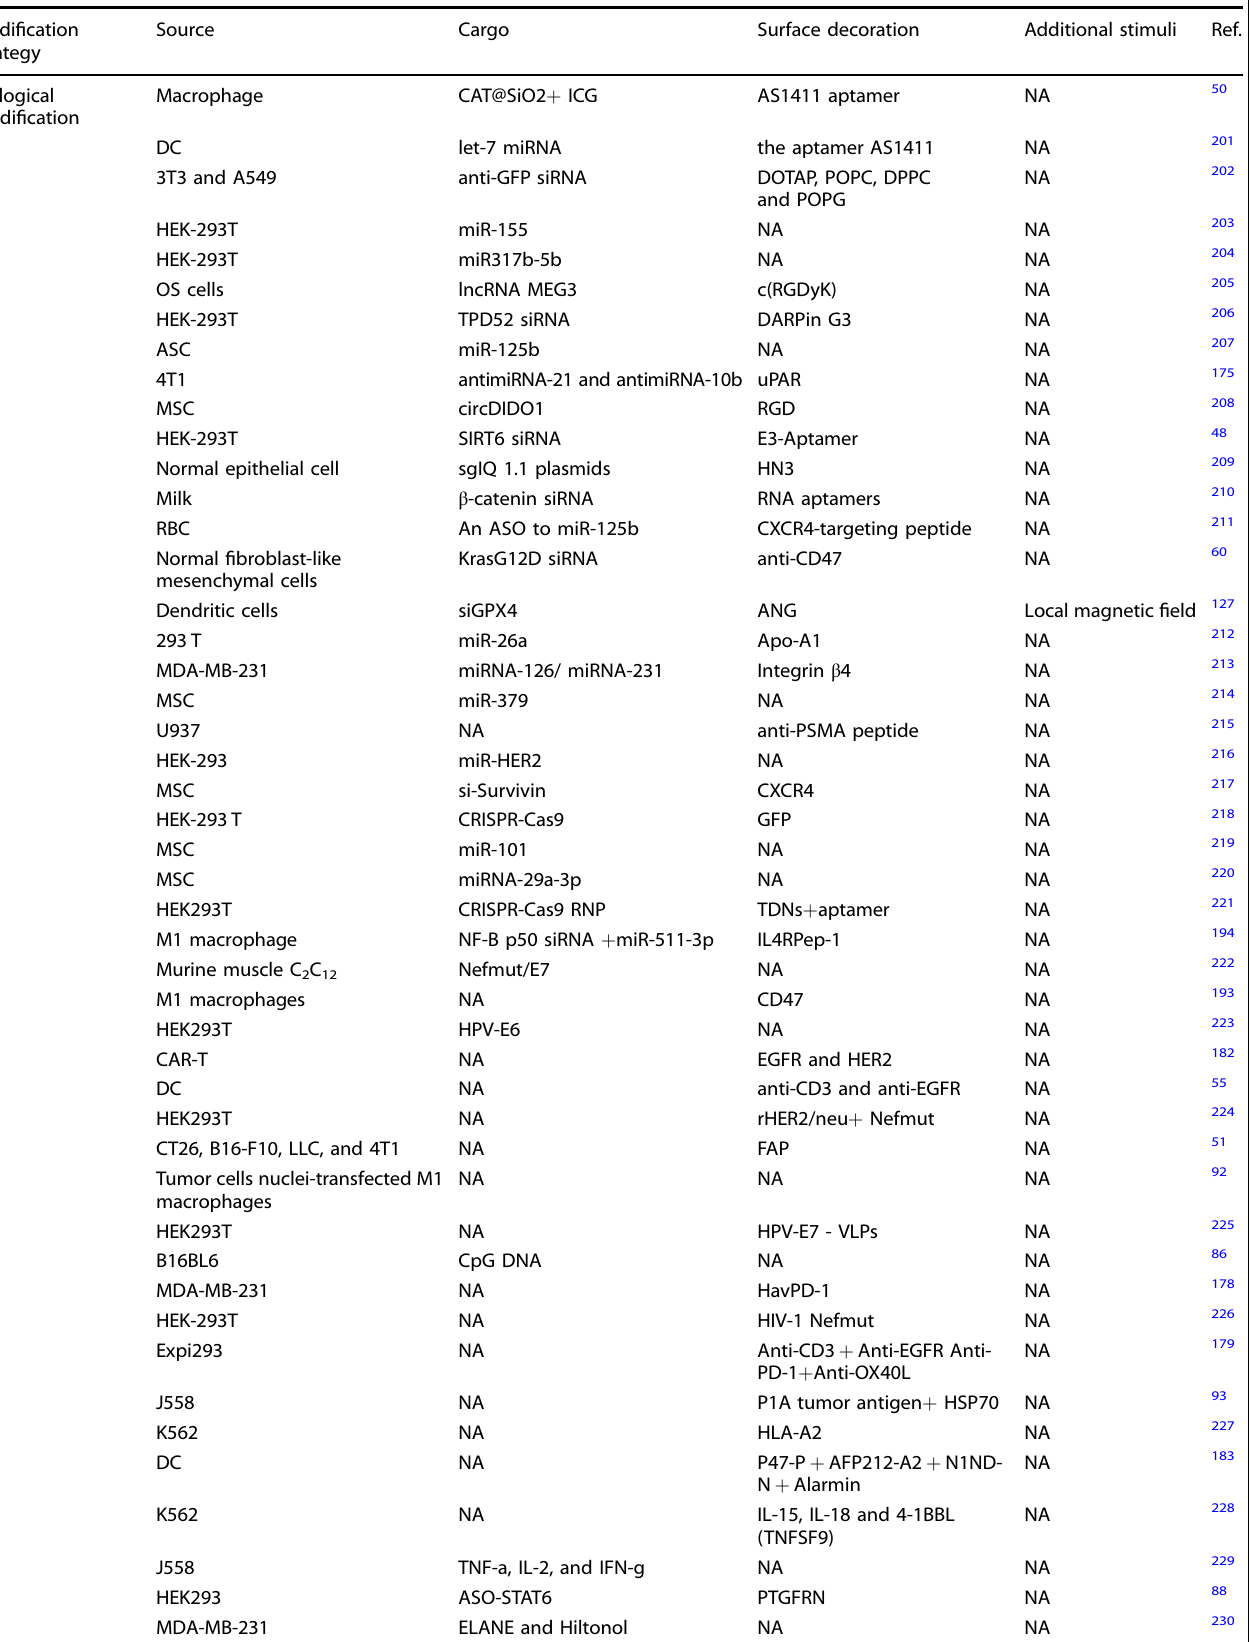
Table 1. The modi fi cation strategy and source of engineered exosomes Modi fi cation Source Cargo Surface decoration Additional stimuli strategy